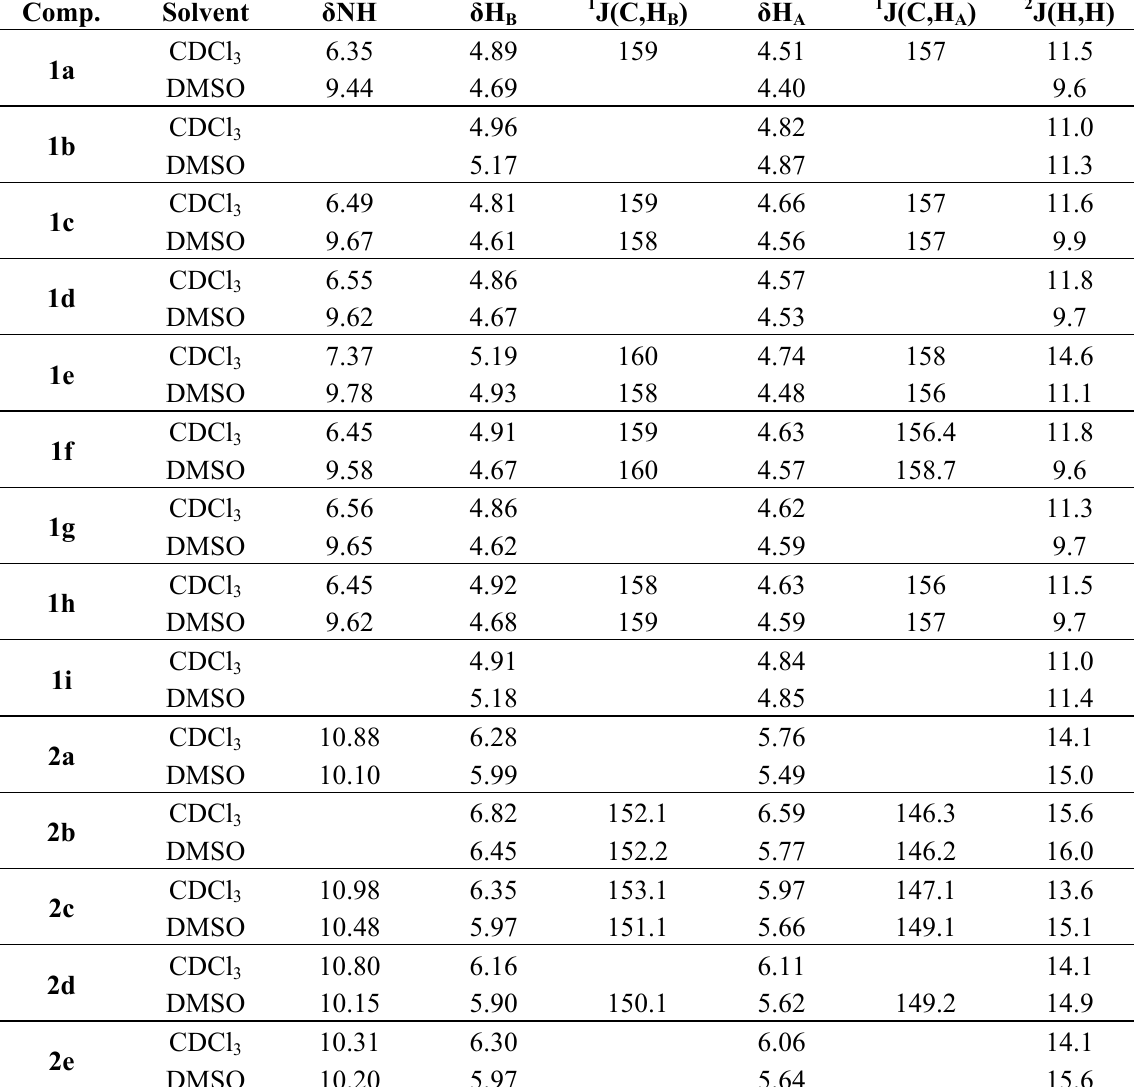
Table 2. 1 H-NMR data of compounds 1–5